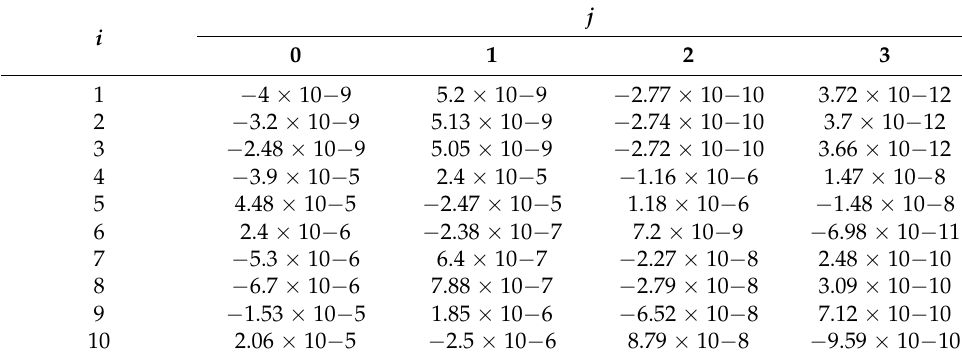
Table 4. Results for the parameters β m,i in Equation